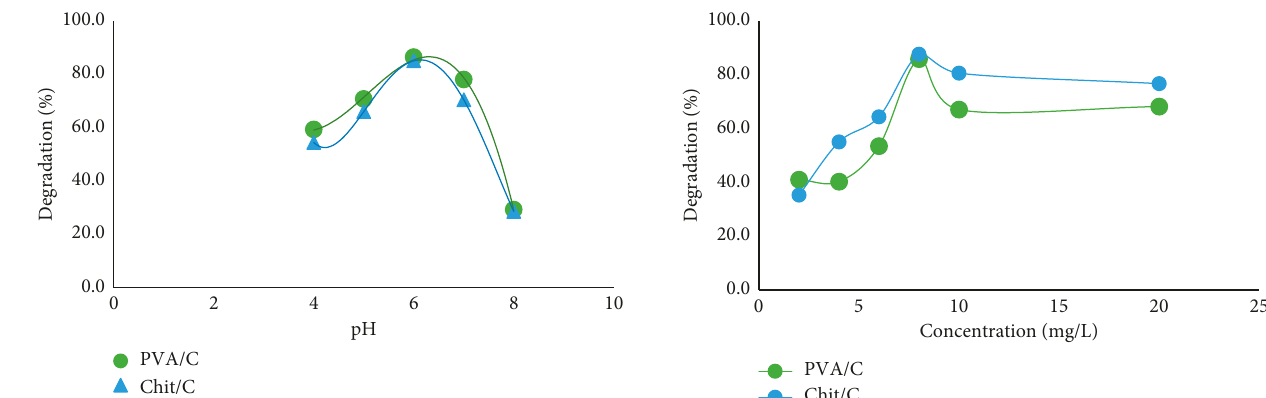
6: Percentage photodegradation as a function of initial concentration of CR